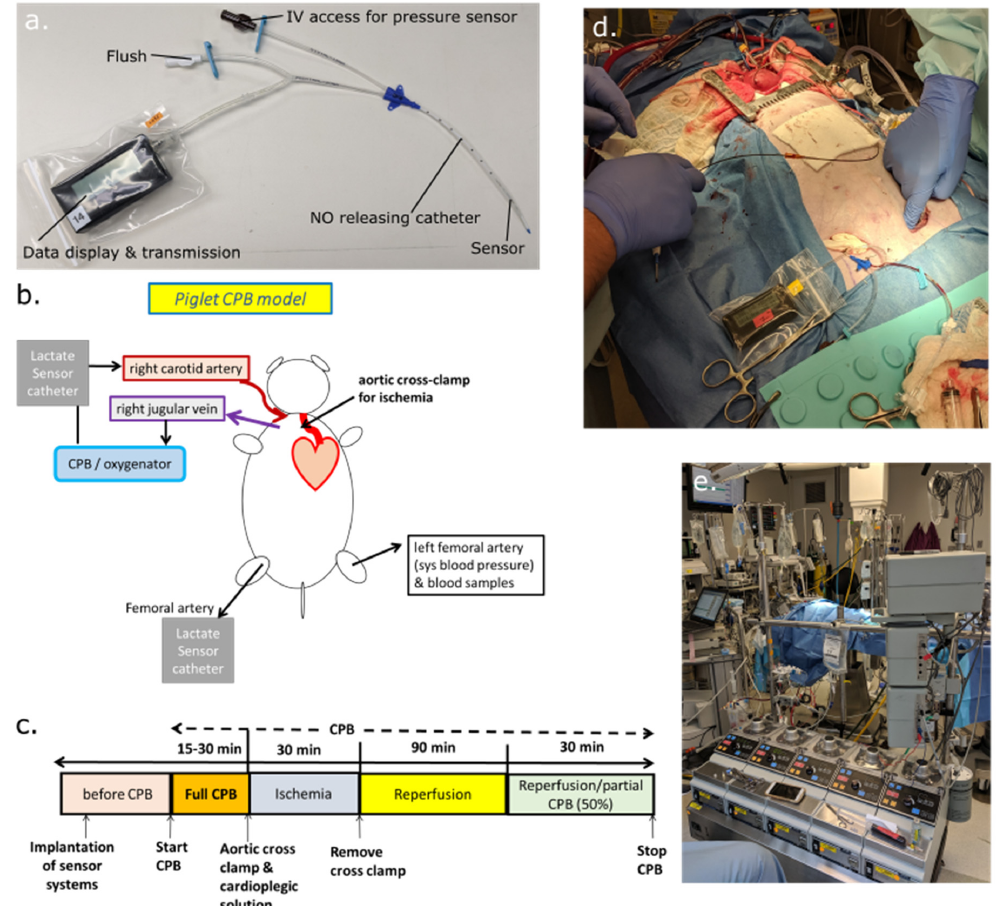
Figure 1. ( a ) An anti ‐ thrombotic 5 ‐ Fr dual lumen central venous catheter with an integrated lactate Figure1. ( a )Ananti-thrombotic5-Frduallumencentralvenouscatheterwithanintegratedlactatesensor sensor and Bluetooth ‐ enabled potentiostat with display was implanted in the animal for 3 h. ( b ) and Bluetooth-enabled potentiostat with display was implanted in the animal for 3 h. ( b ) Schematic of the experimental setup and cardiopulmonary bypass (CPB) circuit. ( c ) Schematic showing the protocol of the open-heart surgery with CPB. ( d ) Intravenous implantation of the device in the femoral artery of a piglet in vivo. ( e ) Clinical pediatric CPB circuit used in the